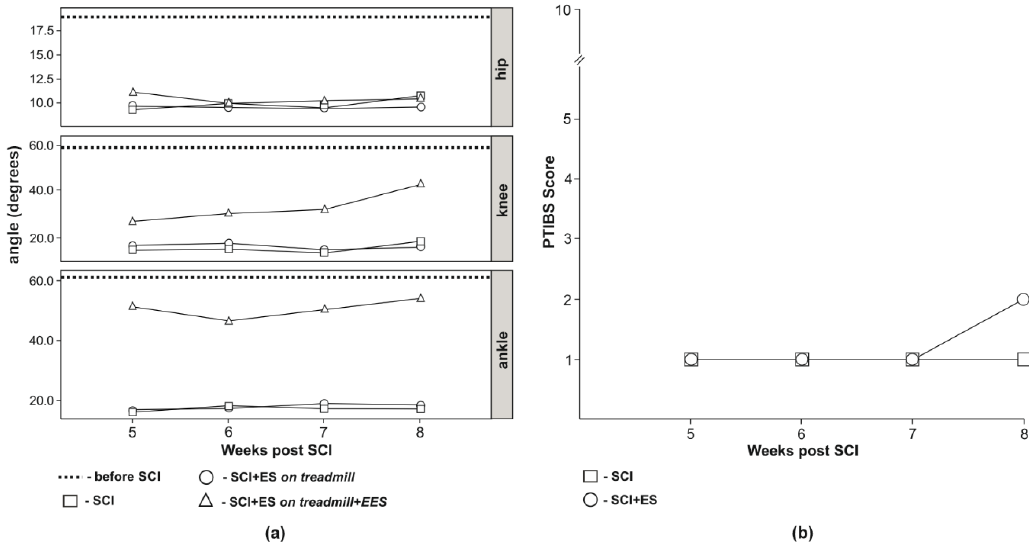
Figure 3. Analysis of the movements in the mini pig hind limbs. ( a )—kinematics analysis of the movements in the joins of the hind limbs (average of 5 steps): the range of motion in hind limbs before SCI (before SCI), after SCI (SCI), and in group with SCI + EES on a treadmill (SCI-EES). SCI + EES on treadmill + EES, the range of movement in hind limb joints during a motor performance with EES in SCI-EES. ( b ) motor activity in mini pig after spinal cord injury assessed with PTIBS scale: SCI–PTIBS (Porcine Thoracic Injury Behavioral Scale) assessment in SCI group; SCI + EES−PTIBS assessment in SCI−EES group.